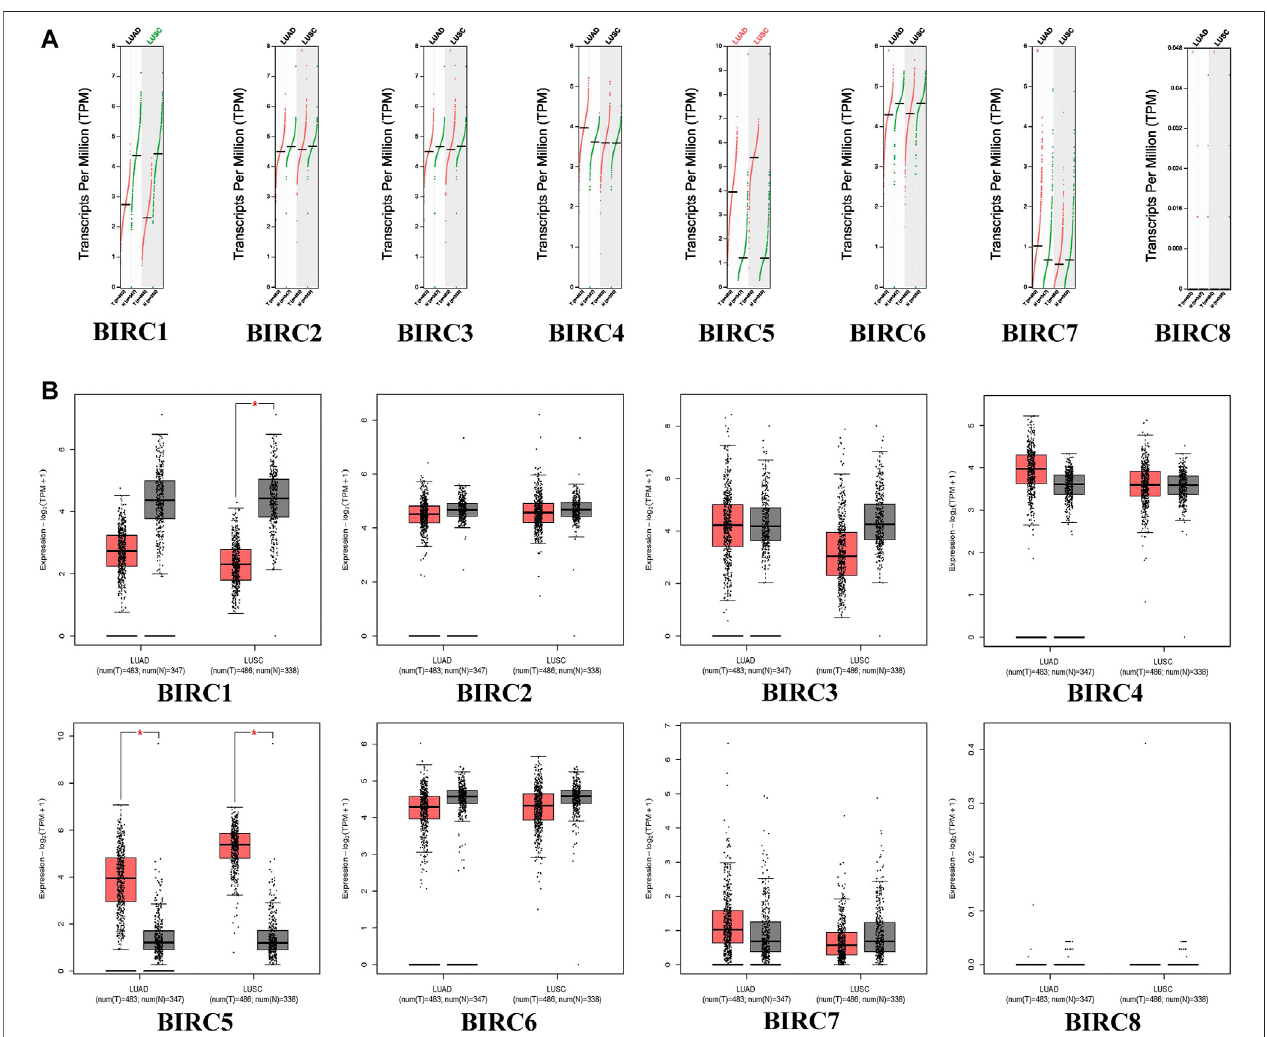
FIGURE1| mRNAexpressionofIAPsbetweenNSCLCandnormallungtissues. (A) ScatterdiagramofIAPsexpressioninNSCLC;reddotsindicatetumortissues andgreendotsindicatenormaltissue.Greentextindicatesthatthegeneexpressionlevelinthetumortissueswaslowerthanthatinnormaltissues,andredtextindicates that the gene expression level in tumor tissues was higher than that in normal tissues. (B) Box plot of IAPs expression in NSCLC; red boxes indicate tumor samples and the gray boxes indicate normal samples. * p < 0.05. NSCLC: non – small cell lung cancer; LUAD: lung adenocarcinoma; LUSC: lung squamous cell carcinoma.